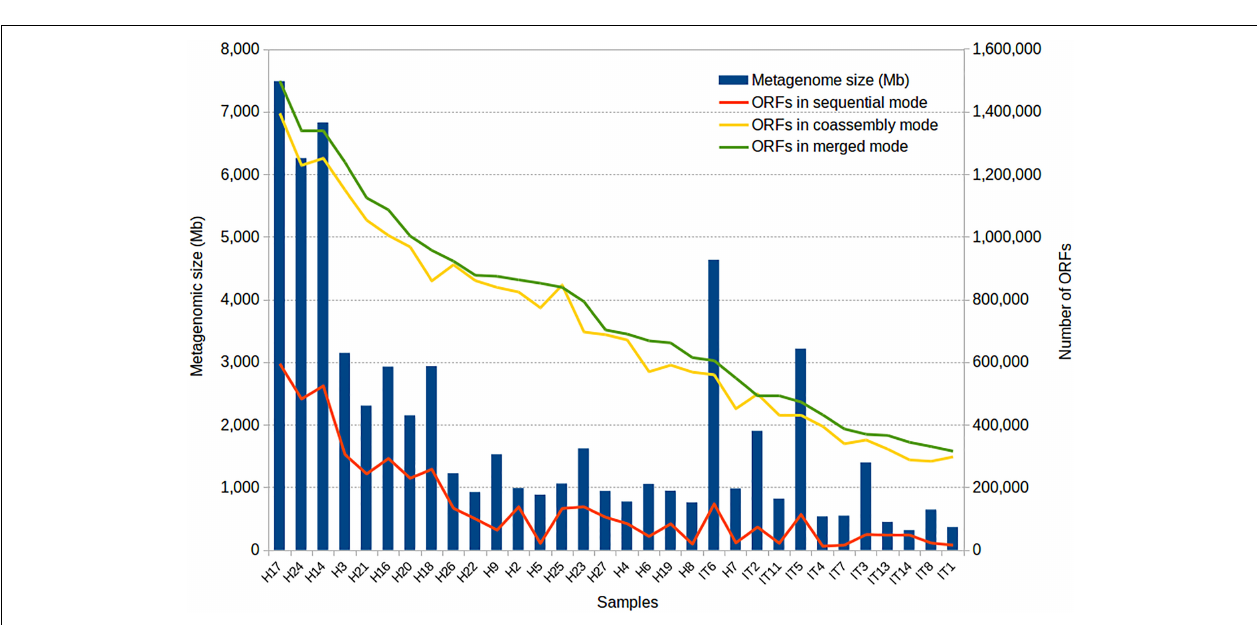
FIGURE 3 | Results of the application of SqueezeMeta to 32 gut metagenomes of Hadza (H) and Italian (IT) subjects. The figure shows the size of the metagenomes and the number of genes obtained by the three modes of analysis.